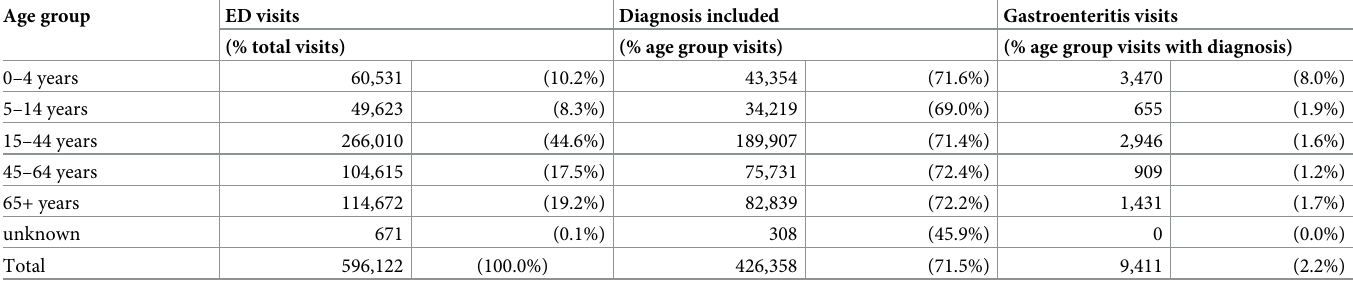
Table 1. ED visits, those including diagnosis coding and those identified as gastroenteritis, by age group during the pre-RV period from 4 July 2011 to 30 June 2013.